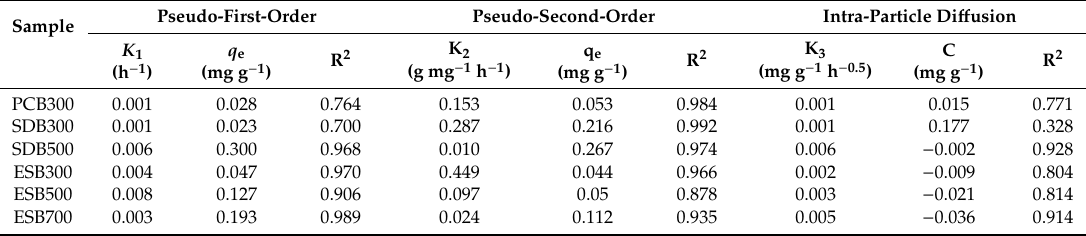
Table 3. Parameters of NO 3 − adsorption kinetics of di ff erent